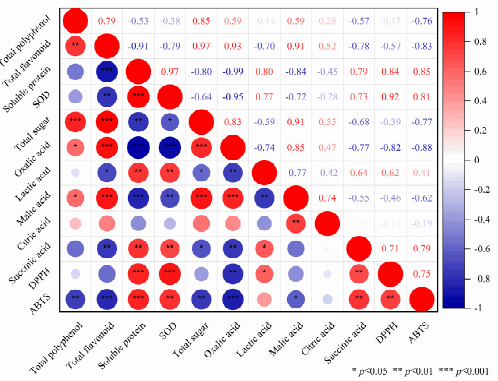
Figure 8. Pearson’s correlation coefficients of antioxidant activities and phytochemical